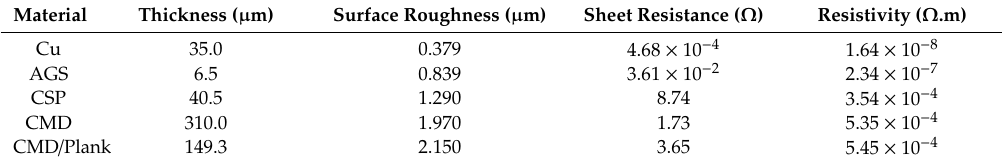
Table 1. The measured characteristics of soil moisture sensor layers.